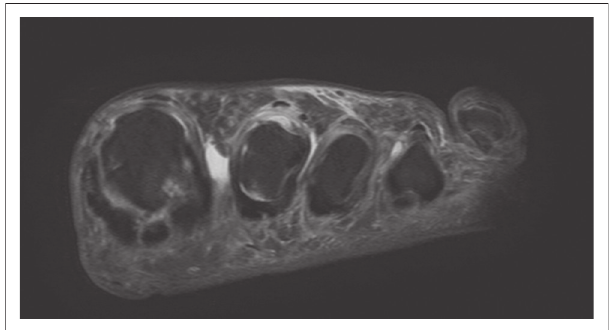
FIGURE 6: Short axis T2 FS MR image of the foot demonstrating an intermetatarsal